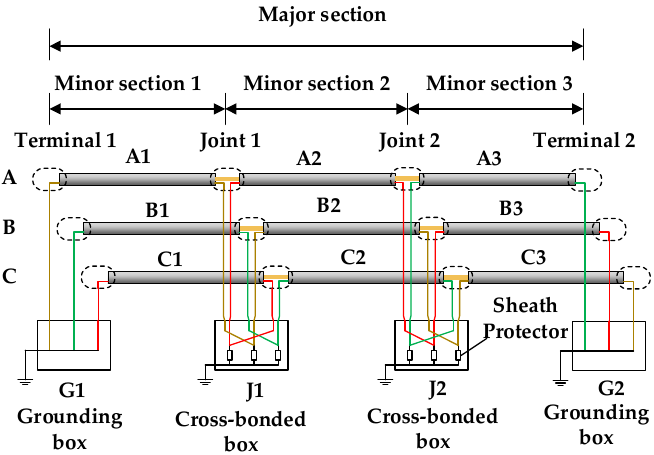
Figure 2. The schematic diagram of a cross-bonded HV cable. In a major section, under normal operating conditions, the equivalent circuit model of the sheath current of the A1-B2-C3 section is shown in Figure 3. The calculation expression of the sheath current is shown in (7), where I m 1 represents the sheath current of the A1-B2-C3 section, U a 1 represents the induced electromotive force of the sheath section A1, and U b 2 represents the induced electromotive force of the sheath section B2, U c 3 is the induced electromotive force of the sheath section C3, Z ma 1 is the equivalent impedance of the sheath section A1, Z mb 2 is the equivalent impedance of the sheath section B2, Z mc 3 is the equivalent impedance of the sheath section C3, R g 1 Indicates the grounding resistance of the G1 end, and R g 2 indicates the grounding resistance of the G2 end. U a 1 , U b 2 , U c 3 contain the equivalent induced electromotive force of adjacent lines.